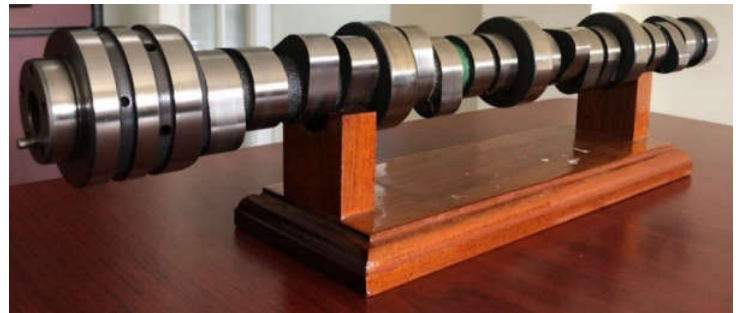
Figure 5. ADI low alloyed with vanadium camshaft 5.7L with 16 intake and exhaust lobes.